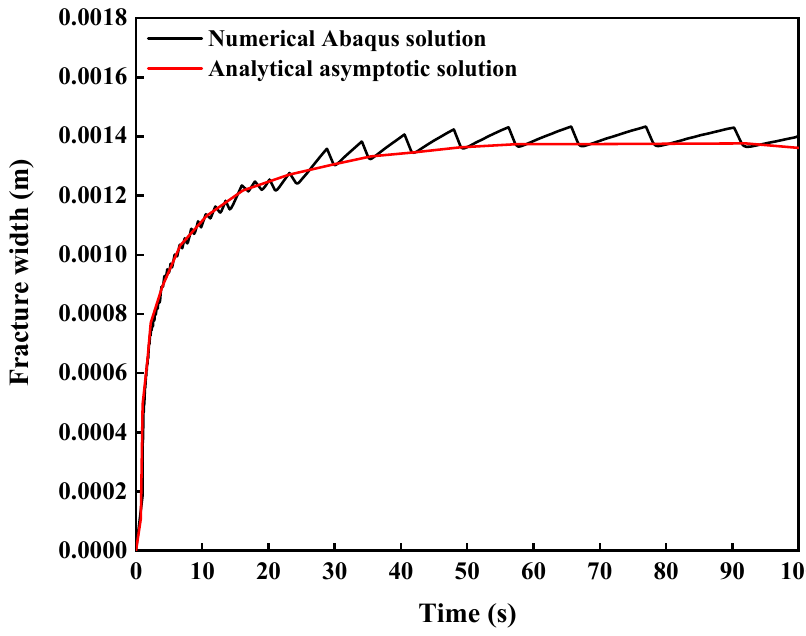
Figure 18. Time evolution of fracture aperture near the injection point (K vertex).